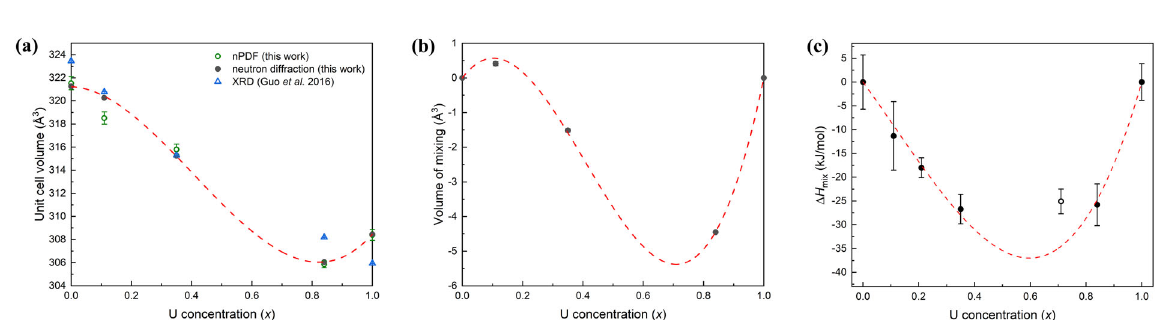
Fig. 2 The re fi ned volumetric and referred enthalpic trends. a Unit-cell volume ( V cell ) fi tted by V cell = 321.2 − 1.0 x − 65.1 x 2 + 53.3 x 3 Å 3 (adjusted R 2 = 0.9998) shown as the dashed red line. Open green circles are from nPDF analysis this work, solid black circles from neutron diffraction with Rietveld re fi nement in this work, and open blue triangles from ref. 12 . b Volume of mixing ( Δ V mix ) modeled by Δ V mix = [11.6(1 − x ) + ( − 41.7) x ] x (1 − x ) Å 3 (adjusted R 2 = 0.9998) shown as the dashed red line. c Revised enthalpy of mixing ( Δ Η mix ) 12 modeled by Δ H mix = [( − 88.6)(1 – x ) + ( − 155.2) x ] x (1 – x ) kJ/mol (adjusted R 2 = 0.9888) shown as the dashed red